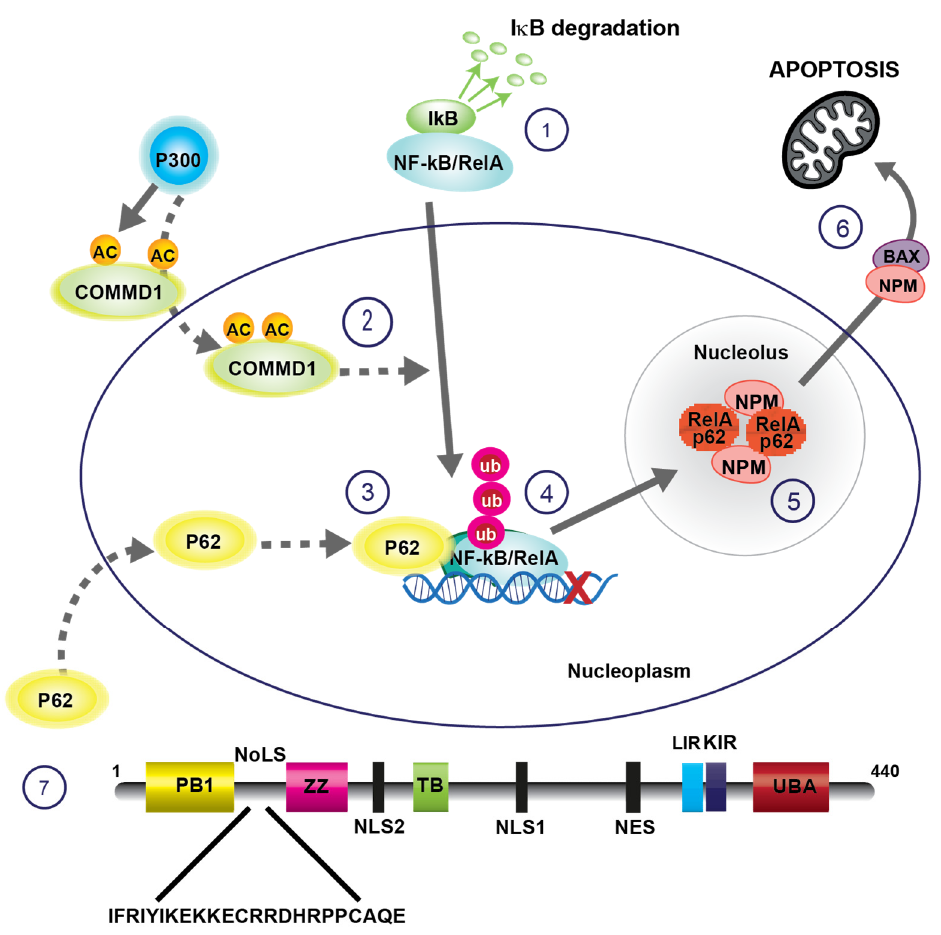
Figure 1. Nucleolar sequestration of RelA mediates apoptosis. 1. I κ B degradation allows nuclear translocation of RelA/NF- κ B complexes. 2. CommD1 is acetylated by p300, allowing it to bind RelA and promote its ubiquitination. 3 and 4. P62 accumulates in the nucleoplasm in response to specific stresses (including proteotoxic stress), binds RelA and other aggresome-related proteins and transports then to nucleolar aggresomes. 5 and 6. Nucleolar RelA causes translocation of nucleophosmin (NPM) to the cytoplasm. There it binds BAX and chaperones BAX to the mitochondria to mediate apoptosis. 7. Schematic of p62 protein domains showing the nucleolar localisation signal (NoLS). PB1-Phox and Bem1 domain; NLS-nuclear localisation signal; ZZ- Zinc finger domain; TB- TRAF6 binding domain; NES-nuclear export signal; LIR-LC3 interacting region; KIR-Keap interacting region; UBA-ubiquitin binding domain. Solid arrows depict main pathway. Dashed arrows represent recruited, facilitating proteins.